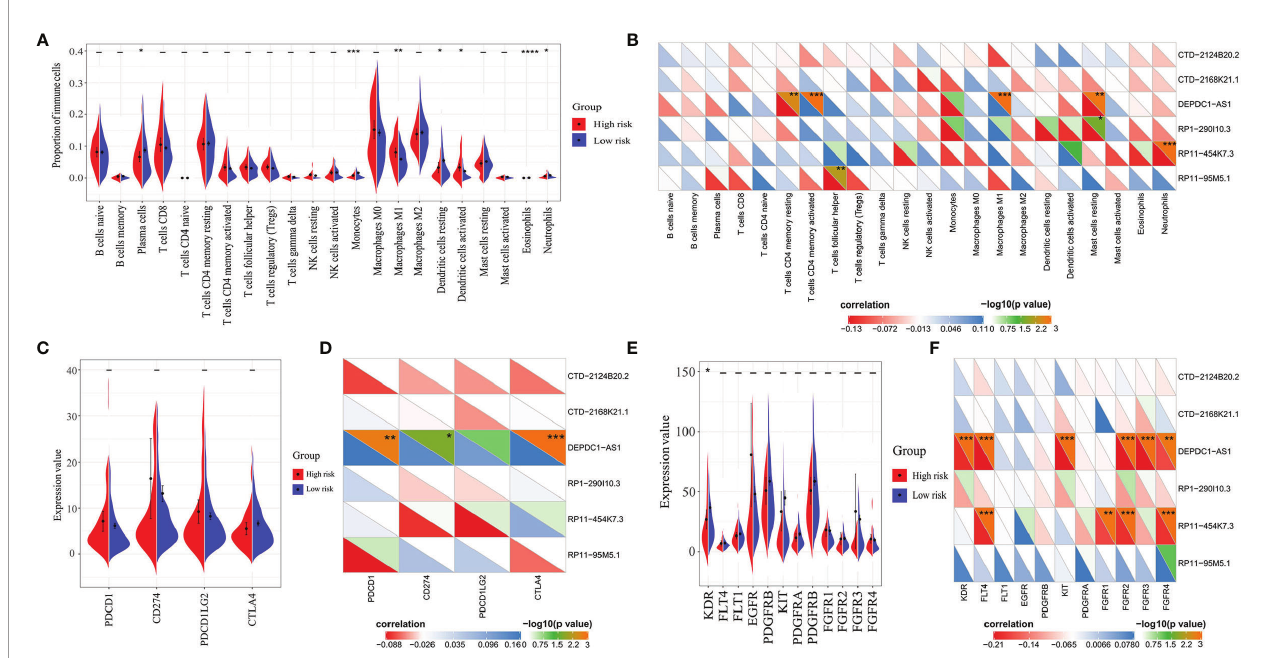
FIGURE 6 | Correlation analysis of lncRNAs with immune cell in fi ltration score, immune checkpoint expression, or antivascular target expression between the high- and low-risk groups. (A) Signi fi cant immune in fi ltrates between the two groups: plasma cells ( P = 0.0233), monocytes ( P = 0.0003), macrophages M1 ( P = 0.0013), dendritic cells resting ( P = 0.0269), dendritic cells activated ( P = 0.0294), eosinophils ( P < 0.0001), and neutrophils ( P = 0.0256). (B) Correlation analysis between lncRNAs in the prognostic model and immune in fi ltration score. (C) Correlation analysis of four immune checkpoints (PD-1, PD-L1, PD-L2, and CTLA4) between the high- and low-risk groups; no signi fi cant difference was found. (D) Correlation analysis between immune checkpoints with the six lncRNAs. (E) Correlation analysis of common anti-angiogenic targets between the high- and low-risk groups. Only KDR (VEGFR-2) showed a signi fi cant difference between the two groups ( P = 0.0314). (F) Correlation analysis between anti-angiogenic targets with the six lncRNAs. Student ’ s t -test was used for the different tests between groups. Correlation analysis was performed by the Spearman test. * P < 0.05; ** P < 0.01; *** P < 0.001; **** P <